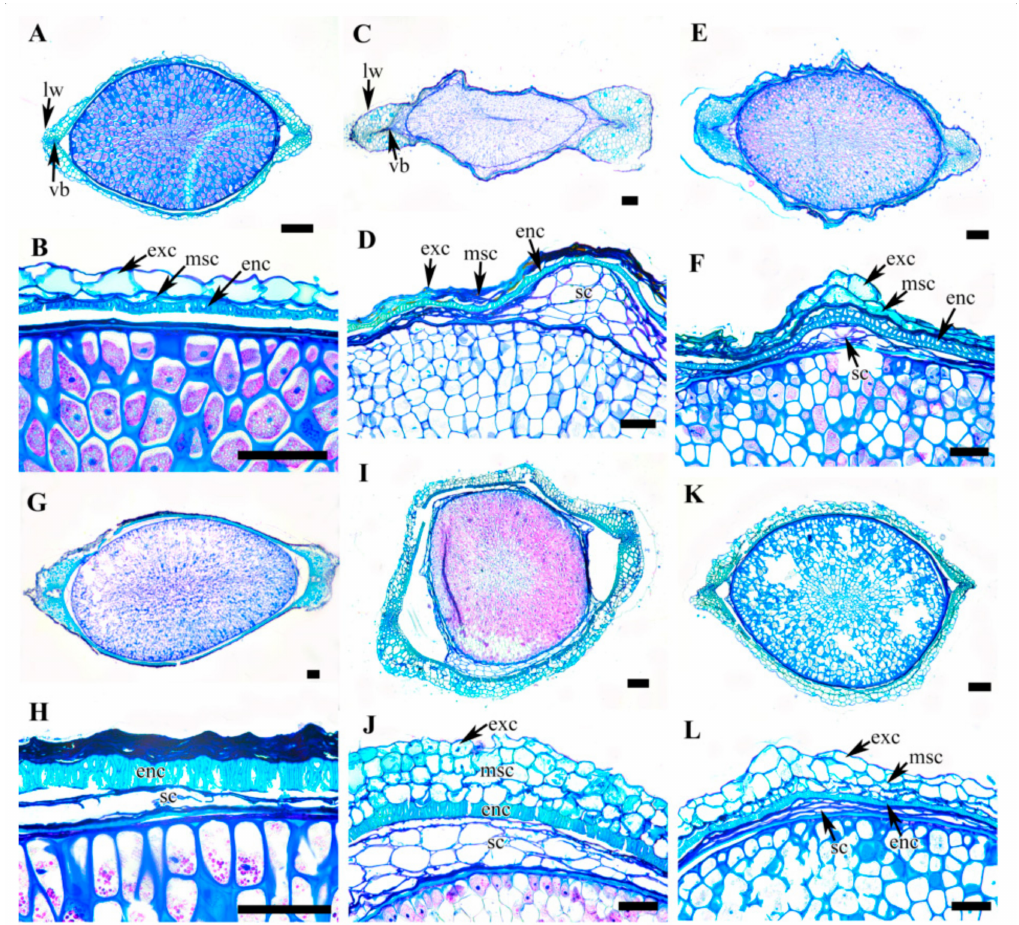
Figure 7. Cross section of achenes of Clematis . ( A , B ) C. serratifolia . ( C , D ) C. fusca var. fusca . ( E , F ) C. fusca var. flabellata . ( G , H ) C. fusca var. violacea . ( I , J ) C. koreana . ( K , L ) C. ochotensis . Abbreviations: enc, endocarp; exc, exocarp; lw, lateral wing; msc, mesocarp; sc, seed coat; vb, vascular bundle. Scale bars: 200 µ m ( A , C , E , G , I , K ); 100 µ m ( B , D , F , H , J , L